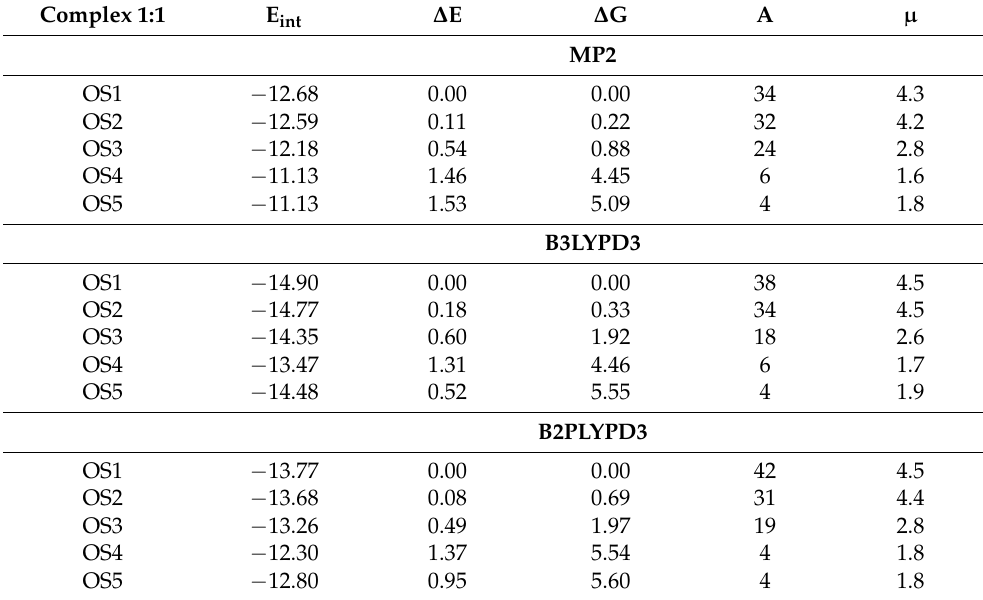
Table 2. BSSE-corrected interaction energies E int , relative energies ∆ E, relative Gibbs free energies ∆ G (kJ mol − 1 ), abundance A (%) and dipole moments µ (Debye) of the HNCO · · · SO